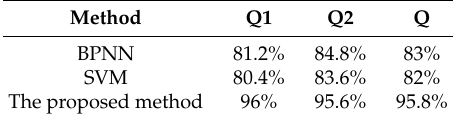
Table 11. Comparison results of three